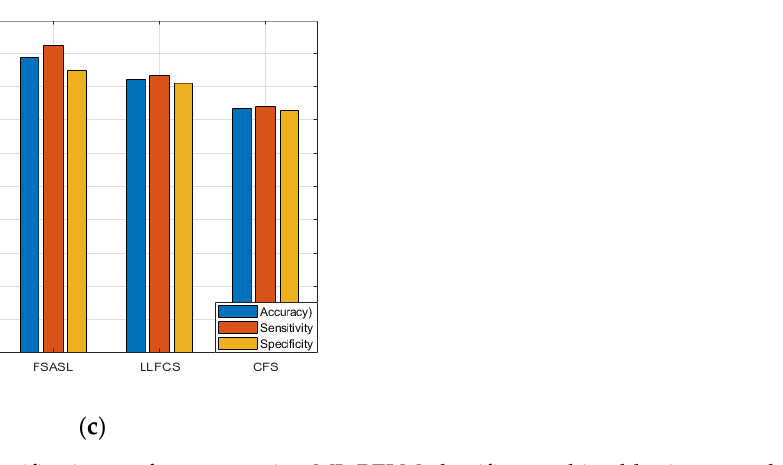
Figure 8. Classification performance using ML-RELM classifier combined brain network using different feature selection methods. ( a ) AD against HC; ( b ) HC against MCI; ( c ) MCI against AD.